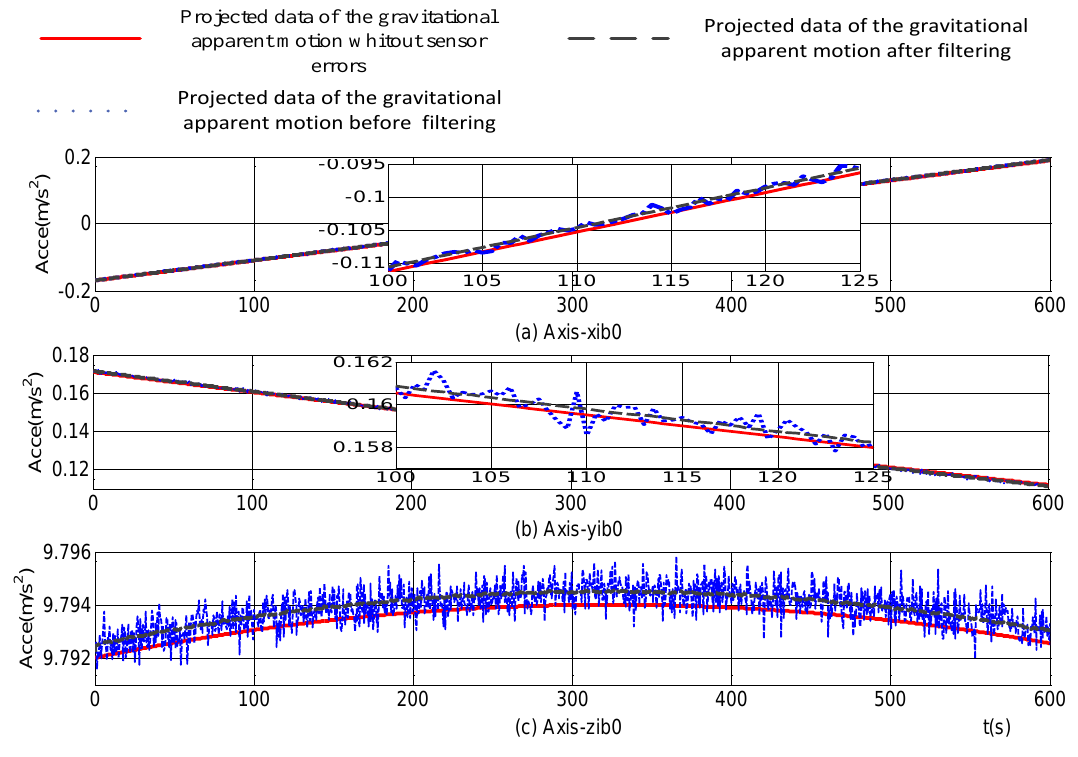
Figure 10. Projections of gravitational apparent motion in the inertial